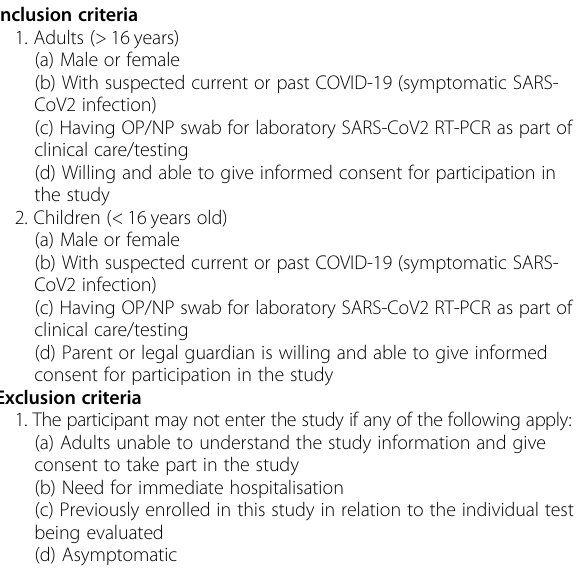
Table 1 Inclusion and exclusion criteria Inclusion criteria 1. Adults (> 16